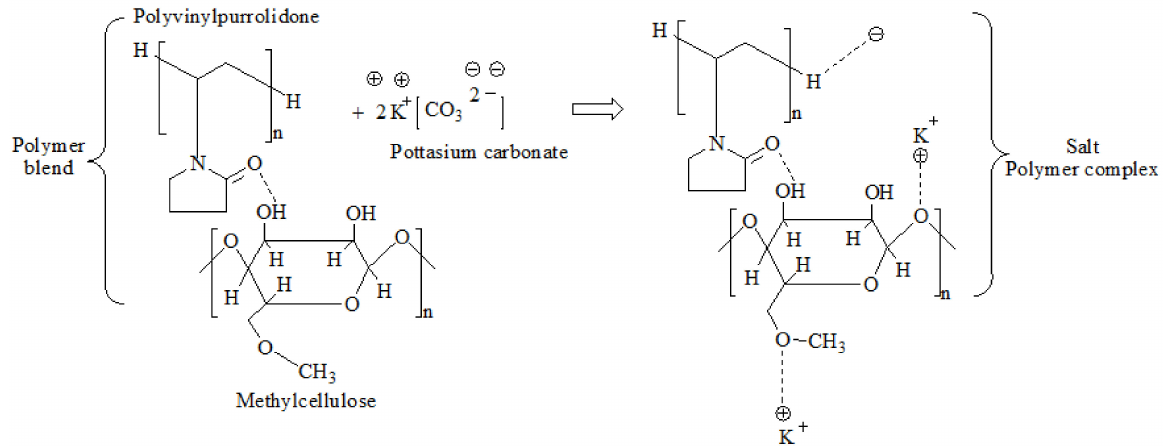
Figure 5. Schematic representation of MC/PVP/K 2 CO 3 polymer-salt